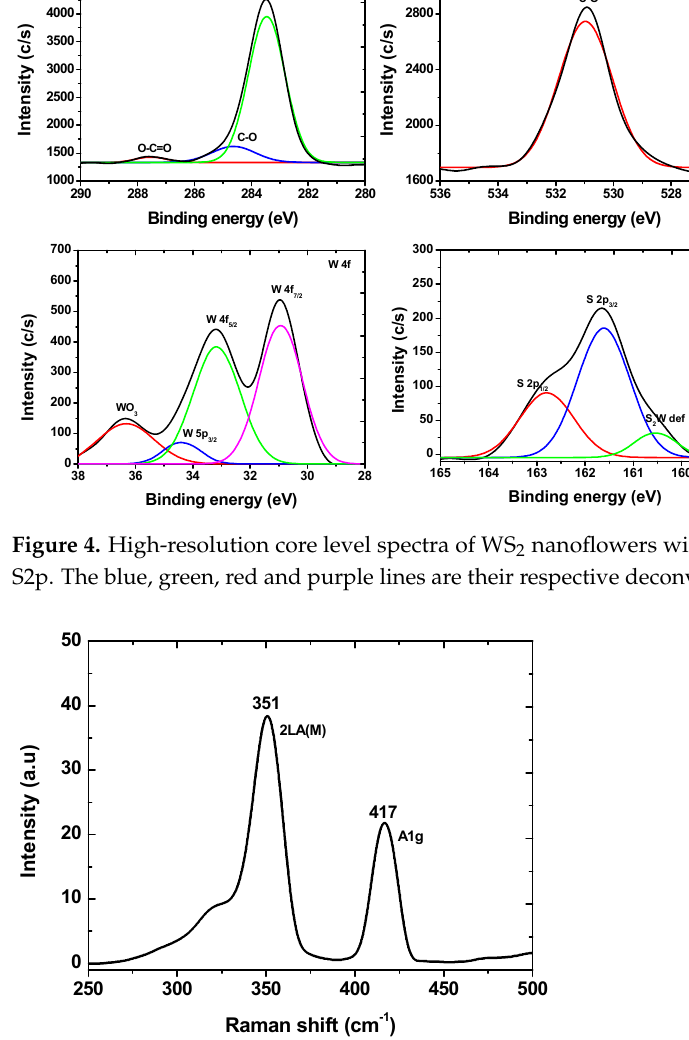
Figure 6. ( A , B ) SEM characterization of WS 2 nanoflowers. Meanwhile, the TEM image from Figure 7A confirmed that the nanoflowers were made up of individual nanosheets. The edges of the nanosheets are exposed and serve as active sites. The microspheres in Figure 7B are consistent with the nanoflower morphology recorded by SEM in Figure 6A,B.